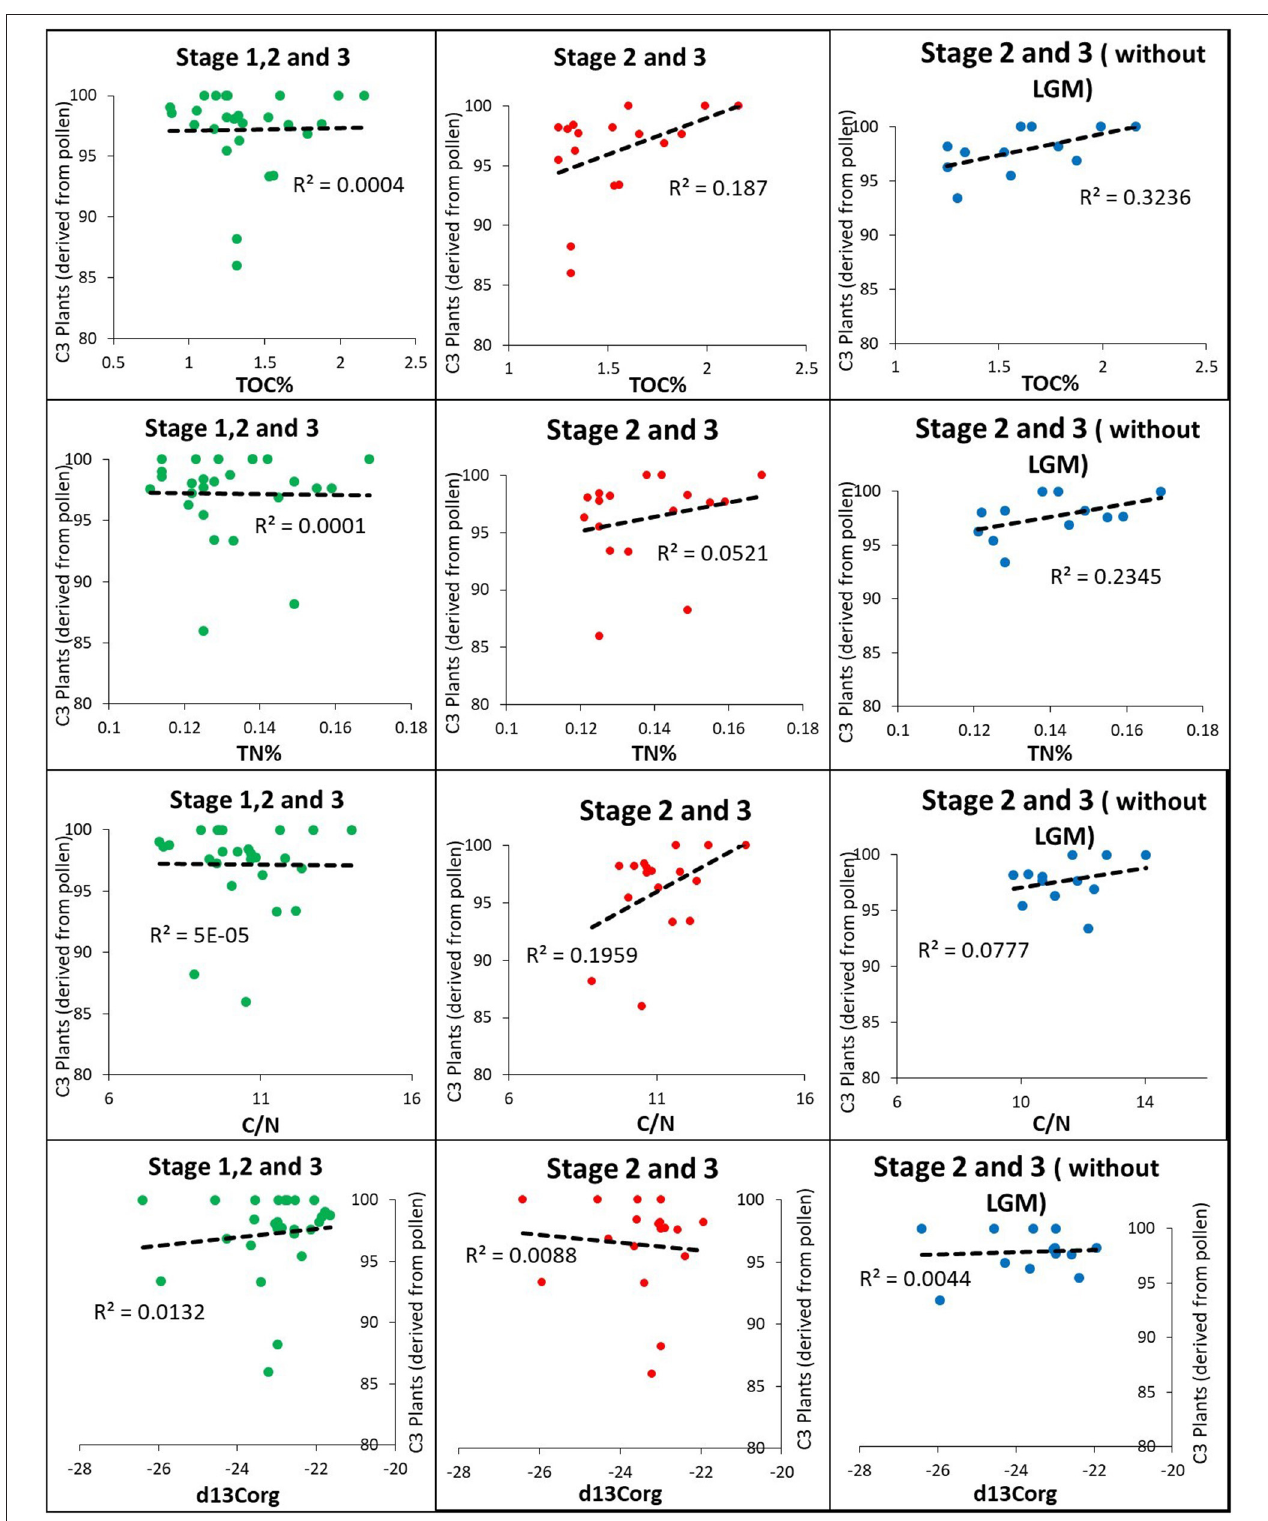
FIGURE 7 | Correlation between deep oceanic geochemical proxies and pollen from NS07 25.